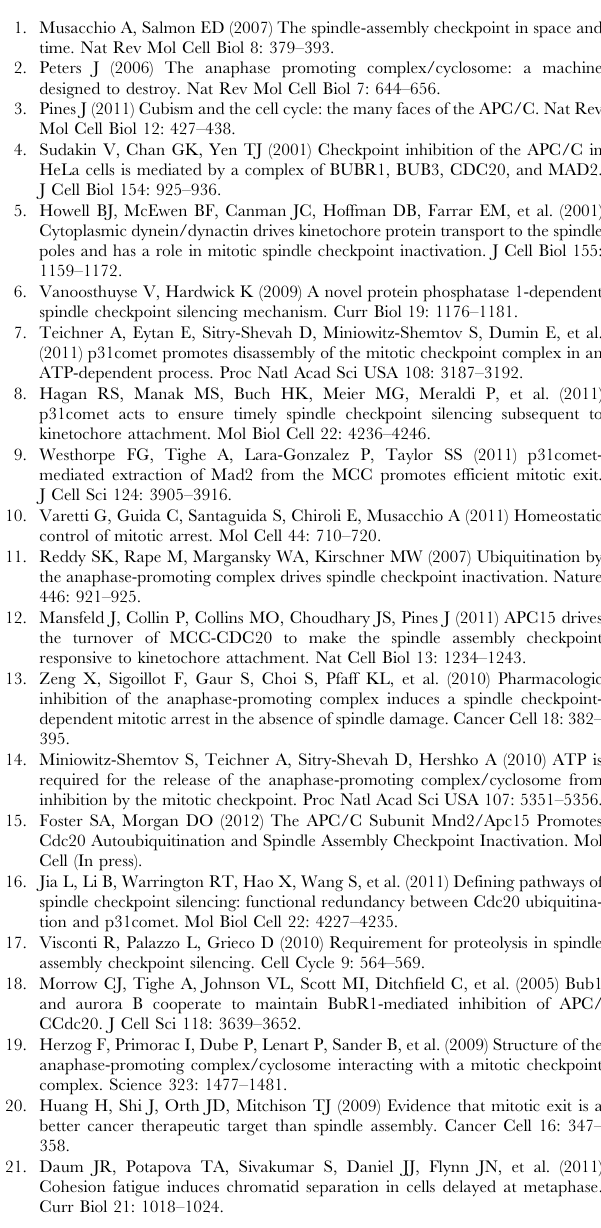
Figure S2 Inhibition of SAC activity blocks the pro- TAME-induced mitotic arrest. (A) Immunoblots of HeLa cells depleted of Mad2 or BubR1 by RNAi. Bub3 was used as a loading control. (B) Scatter plot showing the amount of time cells take from NEBD to metaphase in the presence of 20 m M proTAME and depletion of either BubR1 or Mad2. P values were calculated using two-tailed Mann-Whitney test. Figure S3 Proteasome inhibition increases the amount of MCC by stabilising Cdc20. Immunoblots of immune complexes isolated from mitotic HeLa cells in the presence